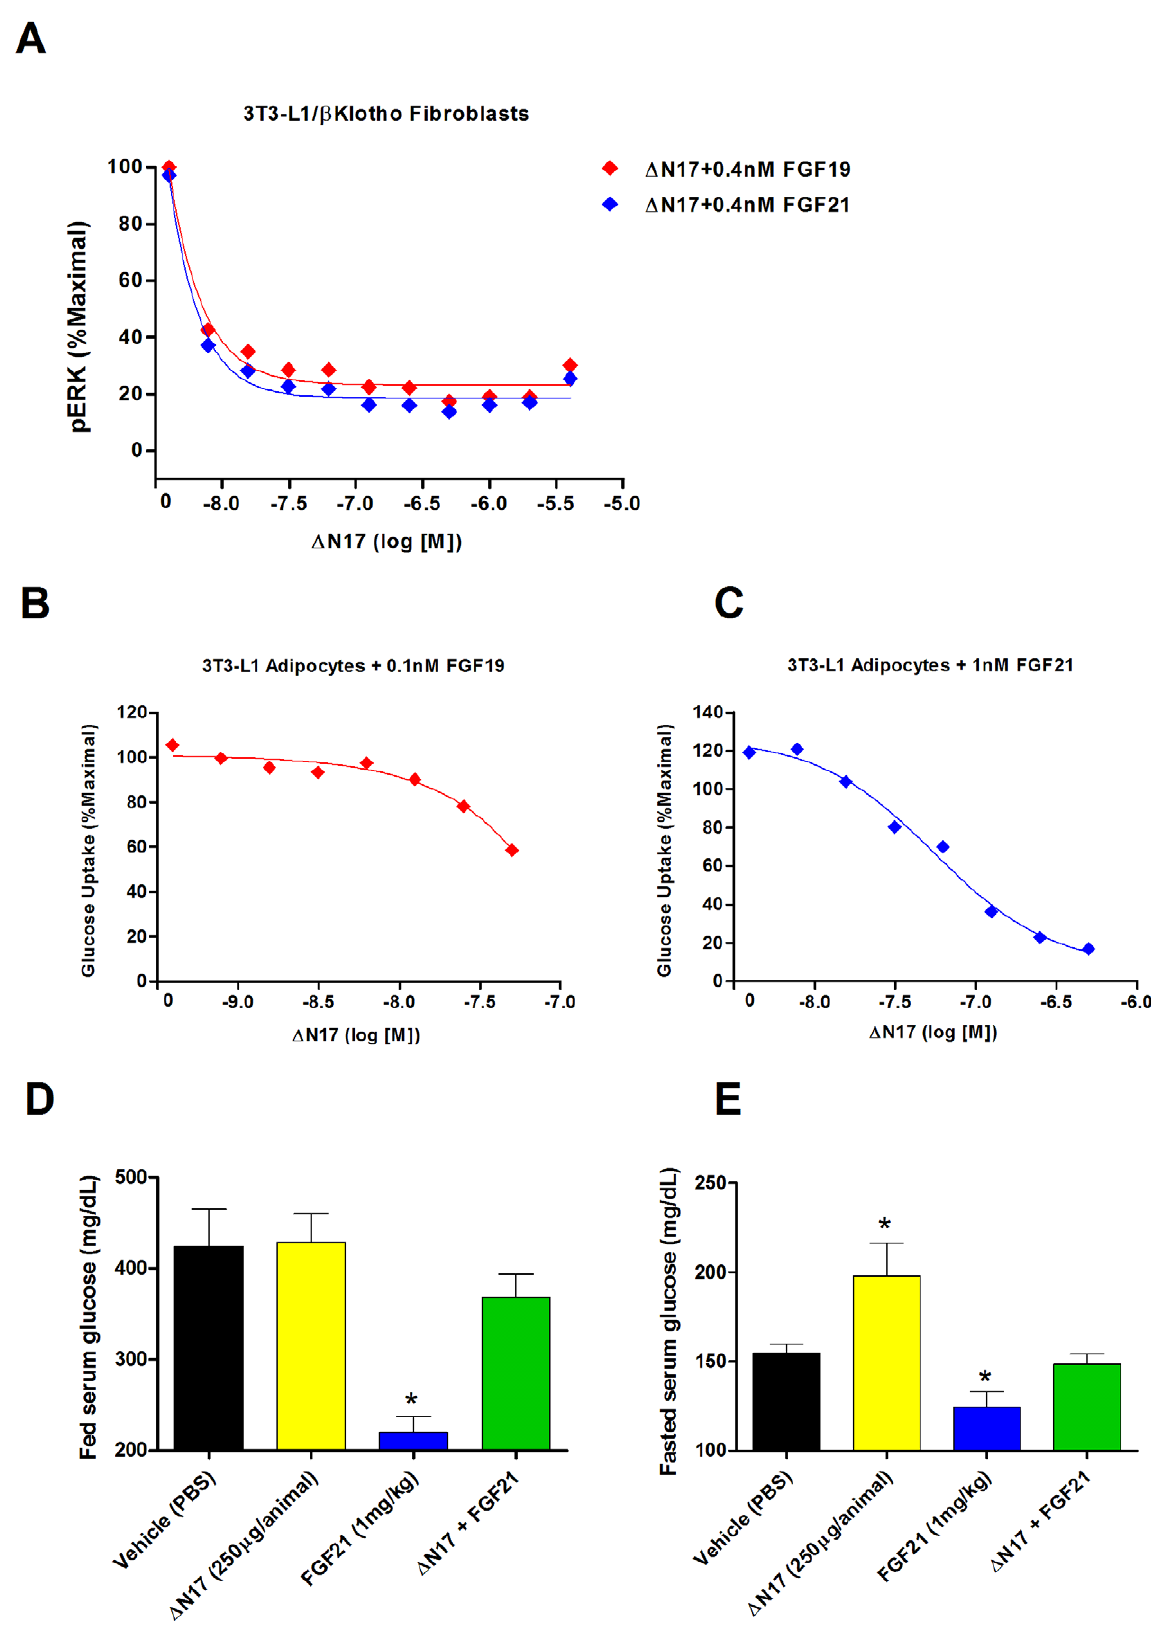
Figure 3. Inhibition of FGF21 signaling also blocks FGF19 action in vitro. Panel 1. In 3T3-L1/KLB fibroblasts co-treatment with the competitive agonist D N17 was able to block the induction of ERK phosphorylation caused not only by FGF21 but also by FGF19 (A). In our glucose